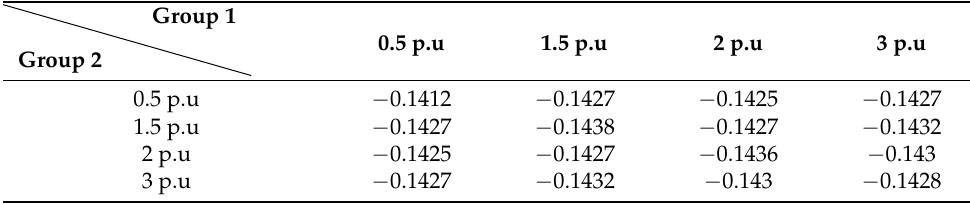
Table 2. Damping coefficient for TM1 of SG under different K i .